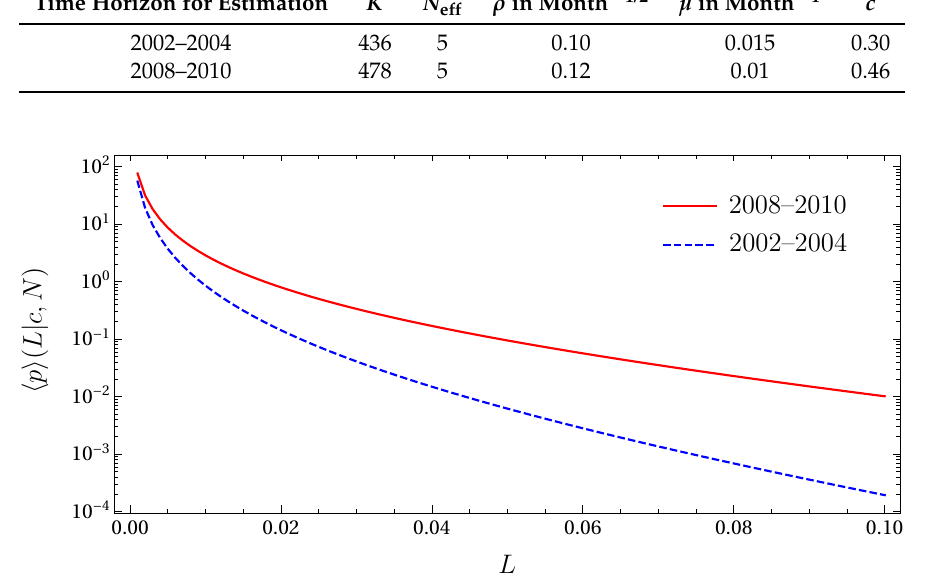
Table 1. Average parameters used for two different time horizons. Taken from (Schmitt et al. 2015). Time Horizon for Estimation K